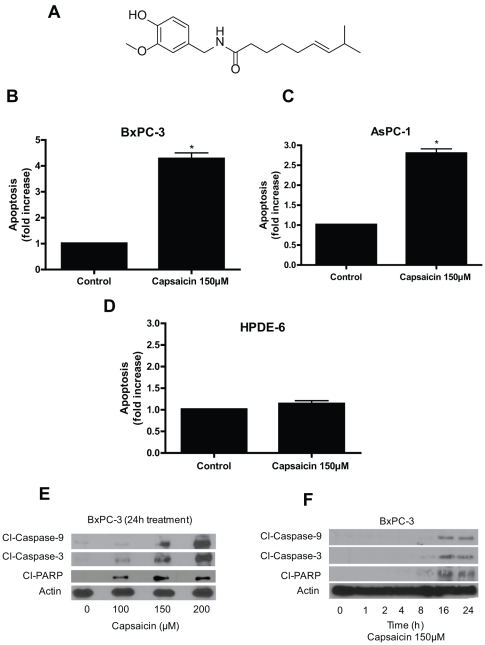
Capsaicin triggers apoptosis in pancreatic cancer cells but not in normal HPDE-6 cells.(A) Structure of capsaicin. Apoptosis inducing effects of capsaicin (150 µM, 24 h) in (B) BxPC-3, (C) AsPC-1 and (D) HPDE-6 cells, was determined using annexin-V/FITC and propidium iodide and analyzed by flow cytometery. Results are expressed as mean ± SD (n = 4) of four independent experiments. *Statistically different when compared with control as analyzed by student's t-test (P<0.05). (E) BxPC-3 cells were treated with different concentrations of capsaicin for 24 h and (F) Cell were treated at different time intervals with 150 µM capsaicin and analyzed by immunoblotting for cleavage of caspase-9, caspase-3 and PARP as described in Materials and Methods. Each blot was stripped and reprobed with anti-β-actin antibody to ensure equal protein loading. These experiments were performed three times independently with similar observation made in each experiment.